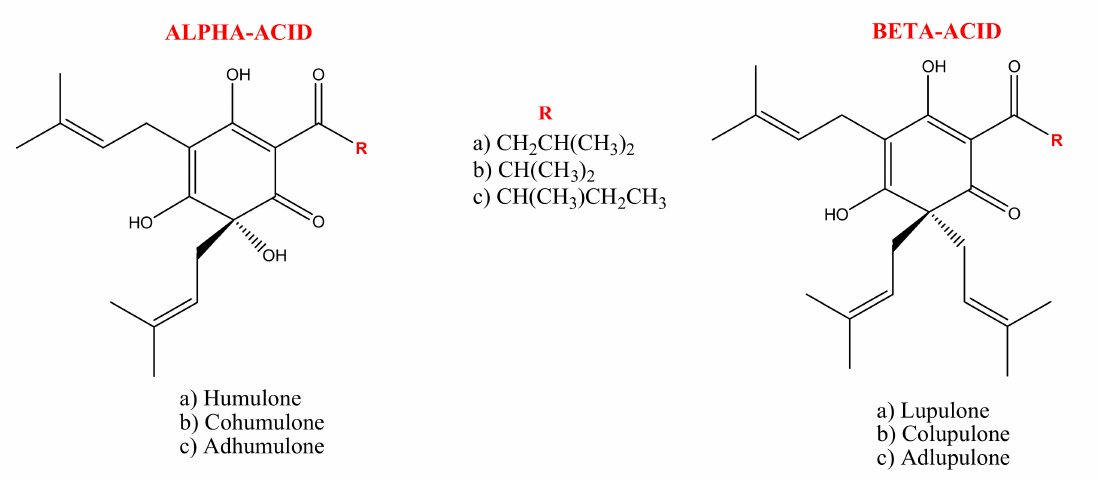
Figure 1. Representation of α -acids or humulones and β -acids or